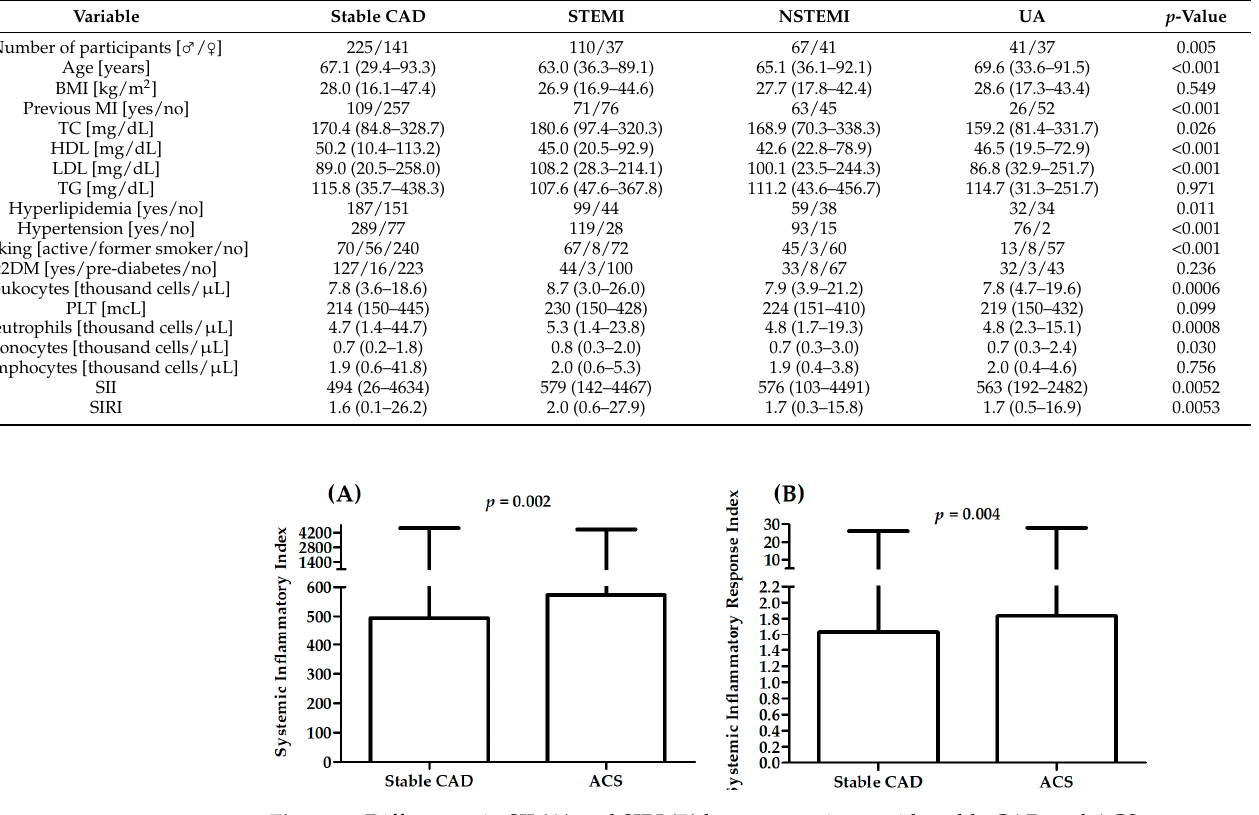
Figure 3. Differences in SII ( A ) and SIRI ( B ) between patients with stable CAD and ACS.